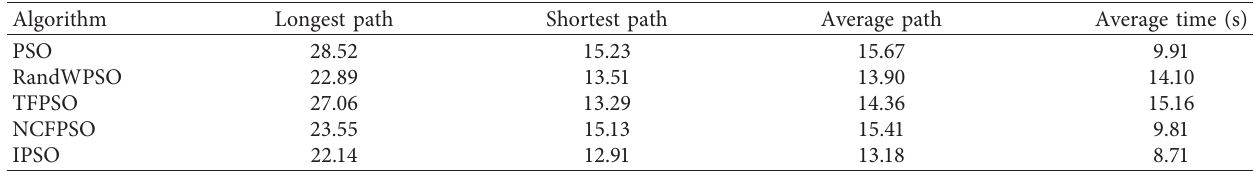
Figure 3: Experimental comparison of five algorithms in a simple environment. (a) Simple environment path plan. (b) Simple environment iteration graph. Table 3: Comparison of path length of five algorithms in simple